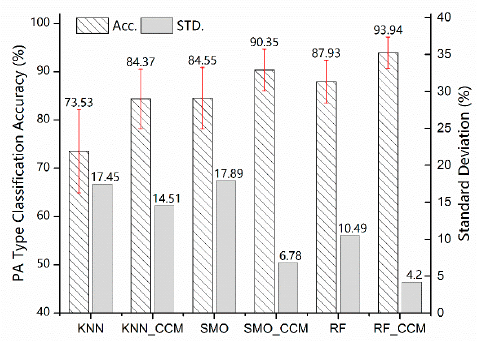
Figure 8. The performance comparison between the CCM and non-CCM classifiers. Table 7. The performance metrics comparison between the CCM and non-CCM classifiers. Algorithms Accuracy Sensitivity Specificity